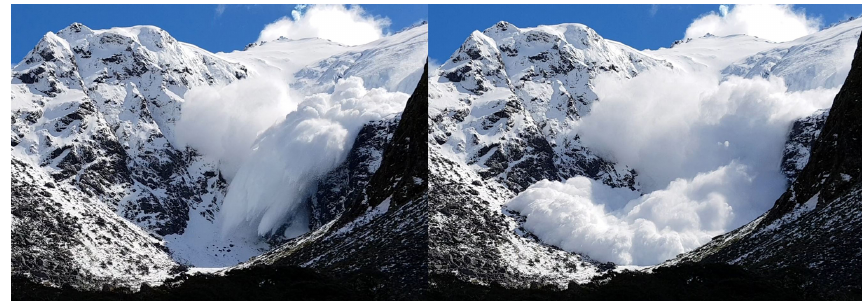
Figure 5. Images of McPherson avalanche event as the core runs over the lower cliff (left panel) and powder cloud accelerates into the valley (right panel) taken from video documentation of event. Courtesy of Downer Ltd. Milford Road